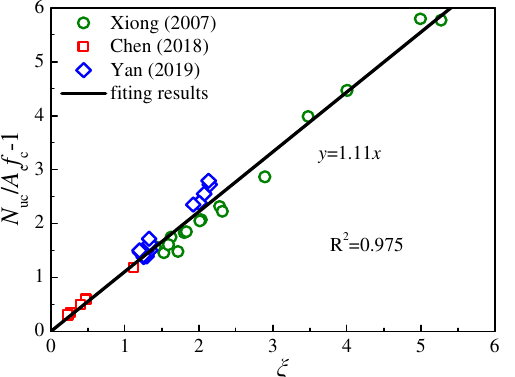
Figure 14. The relationship of N uc / A c f c -1 and ξ. (Chen et al. [33], Xiong et al. [34], Yan et al. [41])